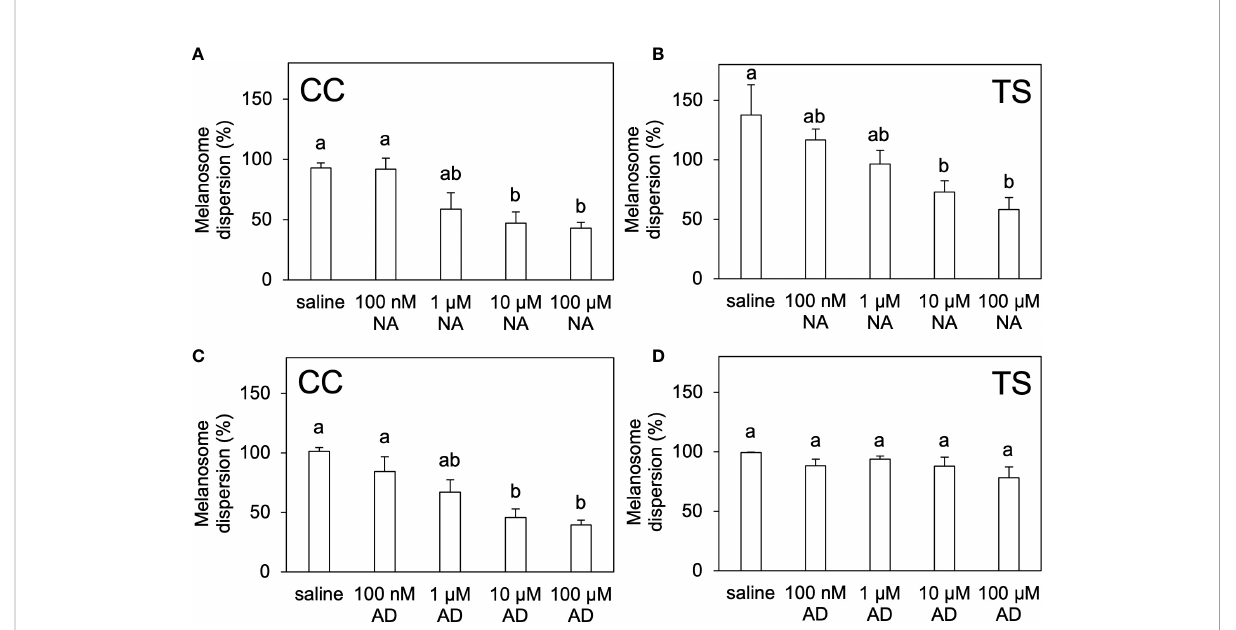
FIGURE 6 In vitro pigment-aggregating effects of noradrenaline and adrenaline. Degree of melanosome dispersion in the scales of CC (A, C) and TS (B, D) treated ex vivo with noradrenaline (A, B) or adrenaline (C, D) . Data are shown as mean ± SE.Different letters indicate statistically signi fi cant differences estimated by one-way ANOVA followed by Tukey ’ s HSD test; P < 0.05, n =